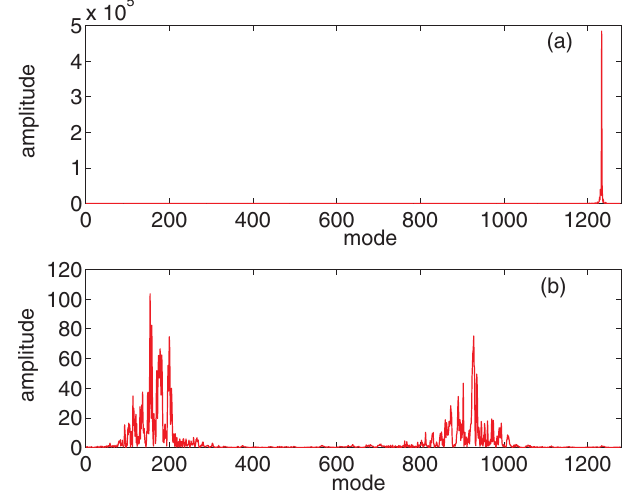
FIG. 21. (Color) Mode spectra of the coupled-bunch instability caused by an electron cloud in a strong bending magnetic field. Plots (a) and (b) show the horizontal and vertical spectra, respectively.